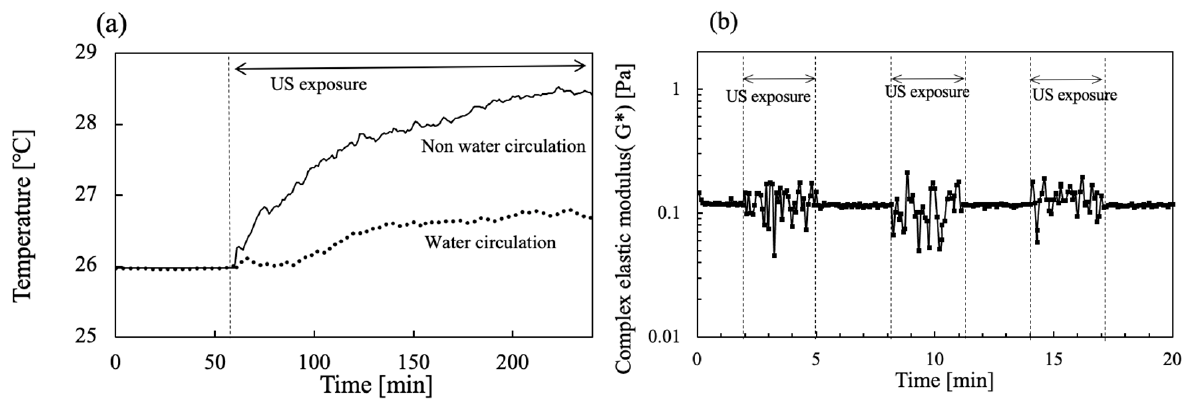
Figure 7. Time change in ( a ) water bath temperature in the absence and presence of water circulation and ( b ) G* in the absence and presence of US exposure for 3 min intervals.